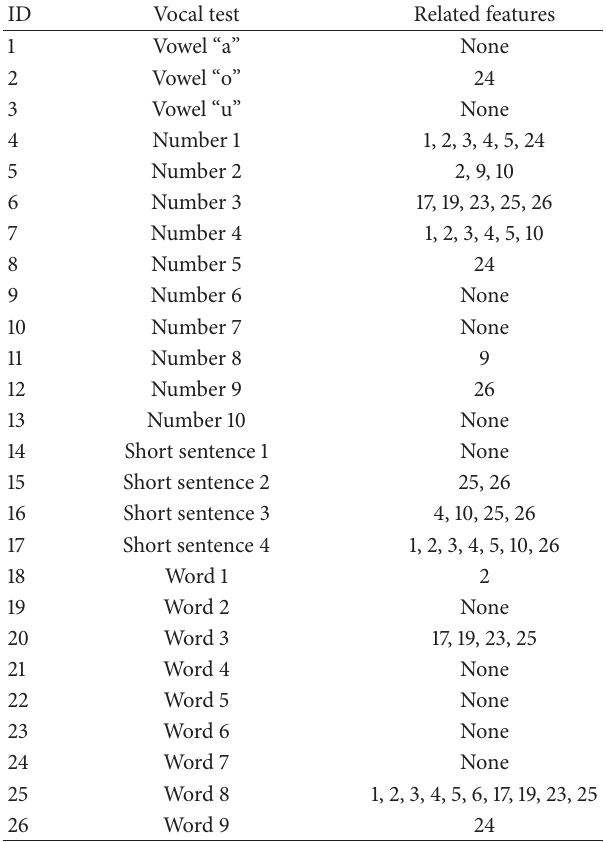
Table 2: Each vocal test and its related features after applying filter- based feature